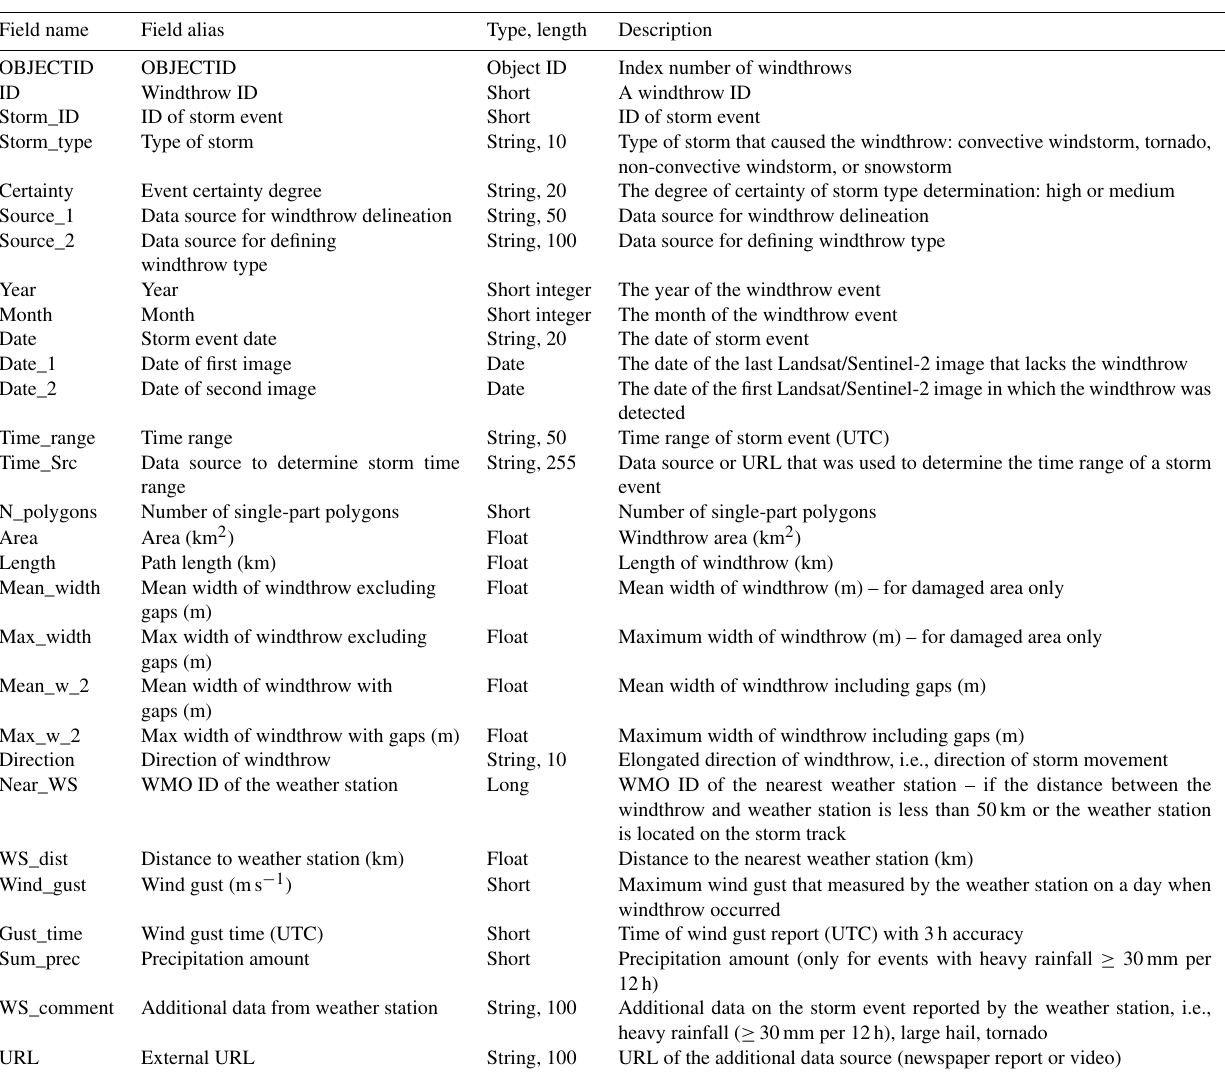
Table 2. Attribute table of the GIS layer of windthrow areas in the forest zone of ER